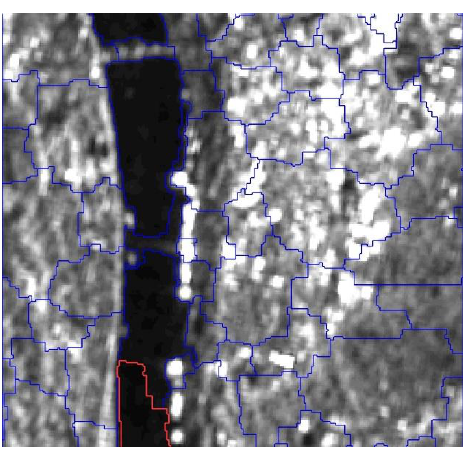
Figure 5. The results of Multi-scale segmentation of GF-3 SAR image